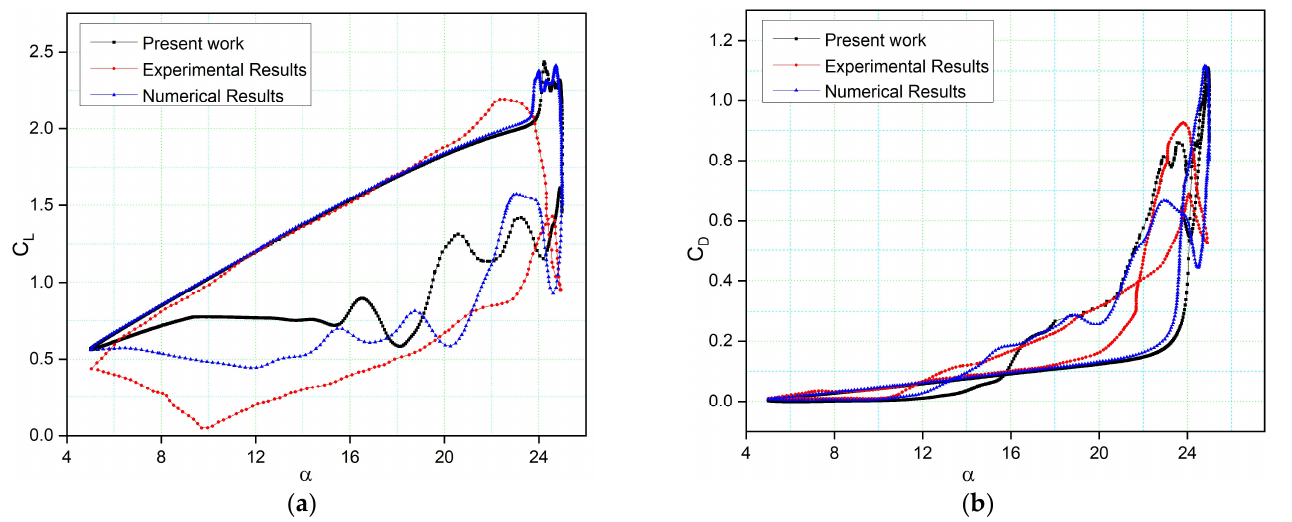
Figure 6. Comparison of our numerical results with experimental results obtained from wind tunnel tests [79] and numerical results [80]: ( a ) lift coefficient; ( b ) drag coefficient variations with the angle of attack.